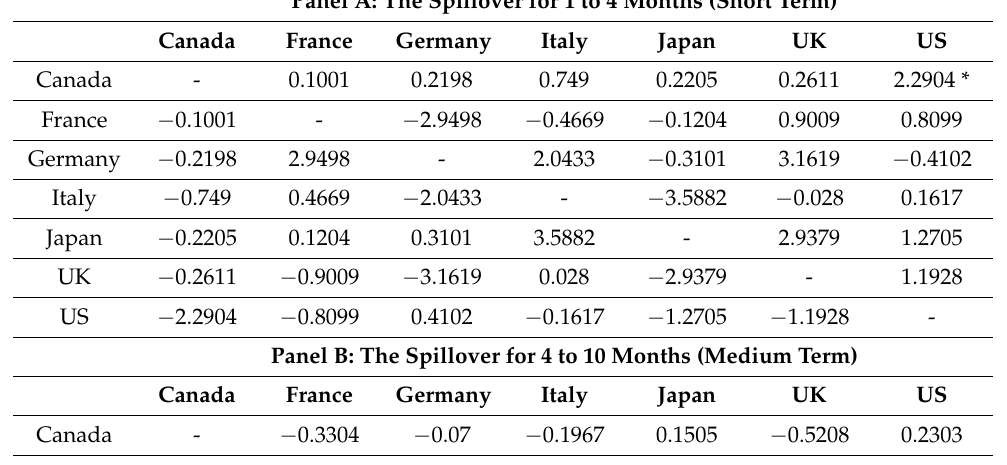
Panel B: The Spillover for 4 to 10 Months (Medium Term)